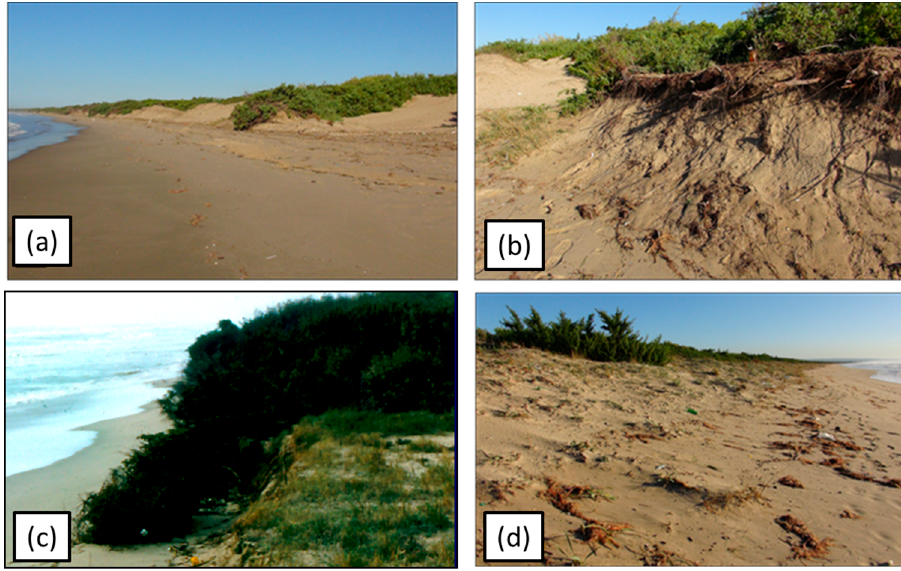
Figure 3. Dune erosion observed in the Gulf of Taranto: ( a ) The Lido Azzurro coast was flooded by storm events in the winter of 2018. Note the erosion of the dune belt; ( b ) a detail of the Lido Azzurro coast with the eroded dune and the exposed plant roots; ( c ) flooding and erosion of a secondary dune in the proximity of the Lato river mouth; and ( d ) dune belt erosion of the Chiatona beach.